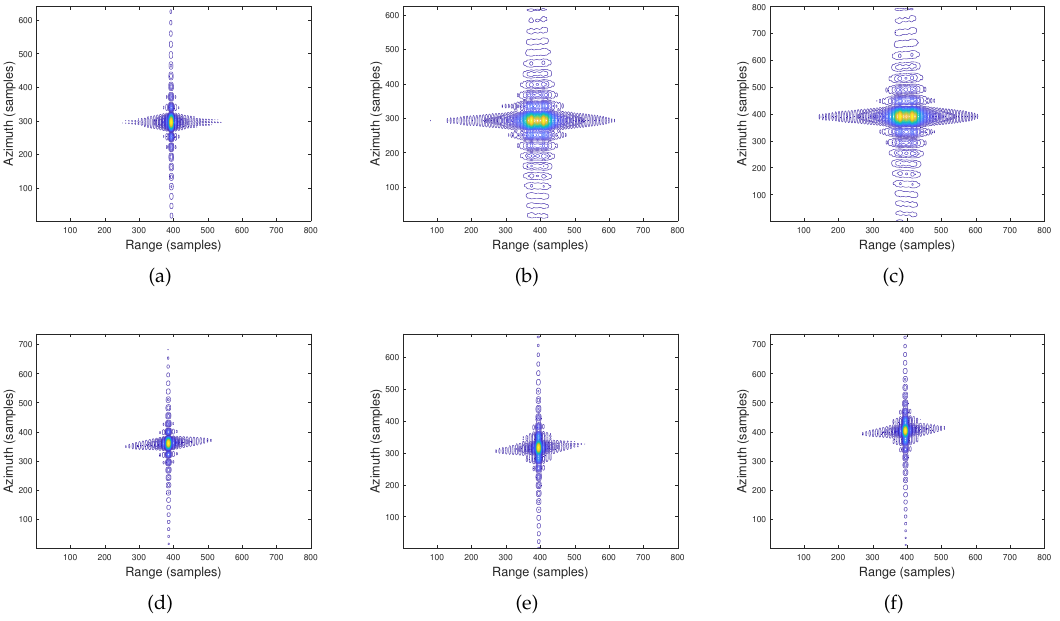
Figure 6. Imaging results. ( a ) Imaging result of P 0 by the traditional algorithm. ( b ) Imaging result of P 2 by the traditional algorithm. ( c ) Imaging result of P 3 by the traditional algorithm. ( d ) Imaging result of P 0 by the proposed algorithm. ( e ) Imaging result of P 2 by the proposed algorithm. ( f ) Imaging result of P 3 by the proposed